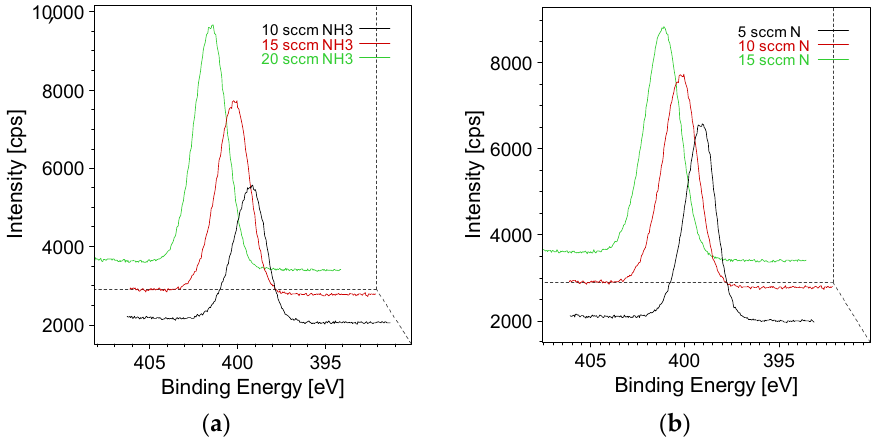
Figure 5. ( a ) Trend of the N 1s intensity as a function of the NH 3 flow rate with N 2 constant at 10 sccm. ( b ) Trend of the N 1s intensity as a function of the N 2 flow rate when keeping the NH 3 constant at 15 sccm.